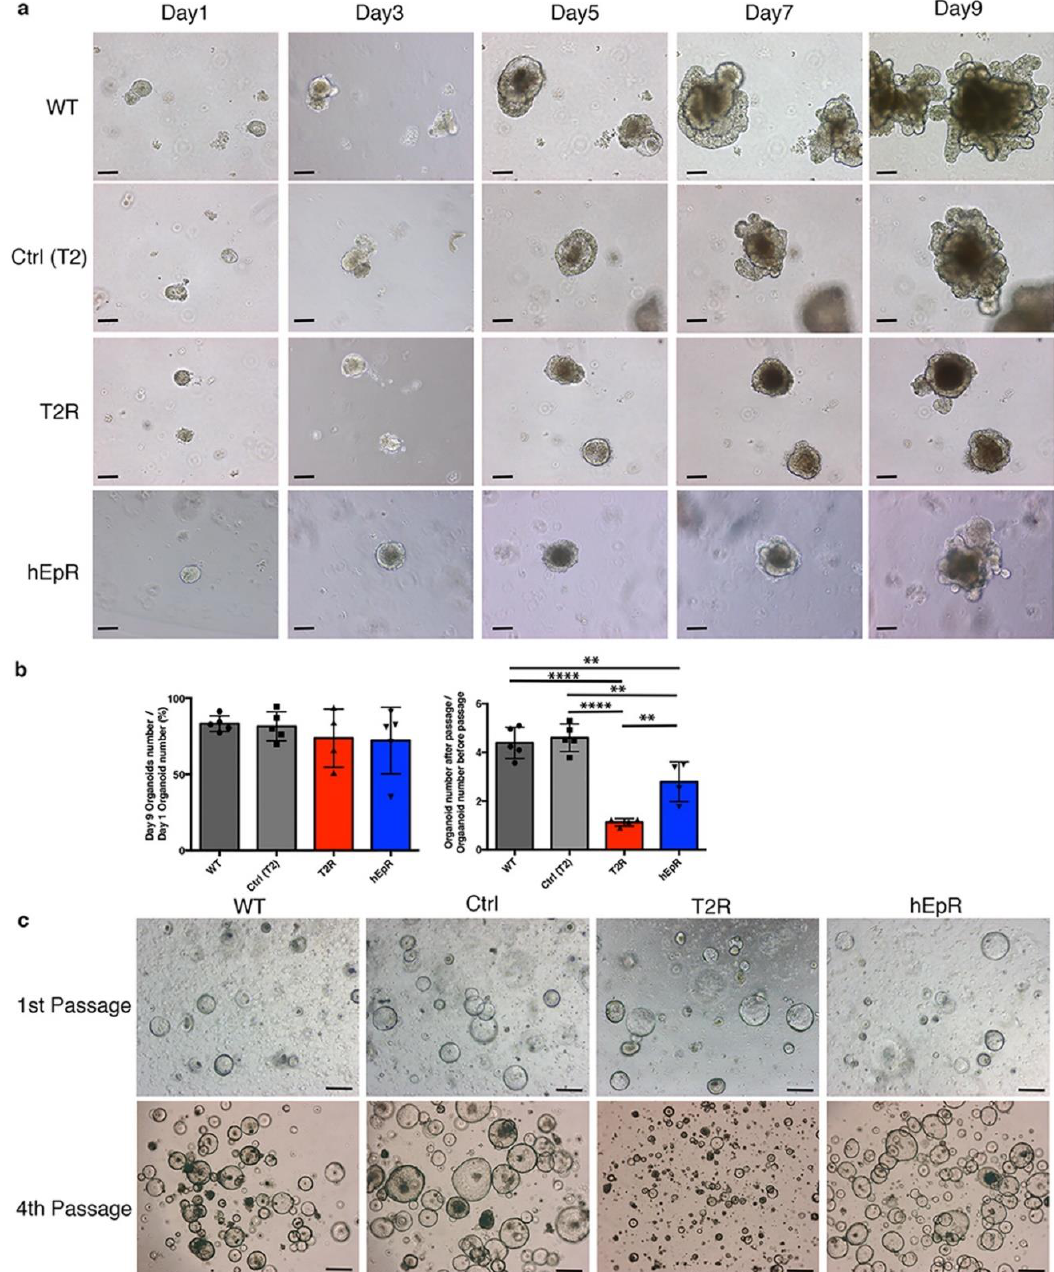
Figure 6. Characterization of organoids and spheroids from TROP2 rescue mice and relevant controls. ( a ) Representative serial phase contrast photomicrographs of IEC organoids obtained from WT, Ctrl (T2), T2R, and hEpR intestinal crypts in vitro. Scale bars, 100 μm . ( b ) Forming and passaging efficiencies of organoids from relevant mice. Organoid-forming efficiencies represent ratios of organoid numbers per well at day 9 to crypt numbers per well at day 1 (left panel). Aggregate data (means ± SD) from four independent experiments are presented. Ten wells were examined in each experiment. Organoid passage efficiencies represent ratios of organoid numbers/well at day 9 of secondary cultures to organoid numbers/well at day 9 of primary cultures (right panel). Aggregate data (means ± SD) from four independent experiments are presented. Six wells were examined in each experiment. ** p < 0.01, **** p < 0.0001 as determined via one-way ANOVA with Tukey’s multiple comparison test. ( c ) Representative phase contrast photomicrographs of spheroids from WT, Ctrl(T2), T2R, and hEpR mice on day 2 after initial passage and fourth passage as indicated. Scale bars, 100 µ